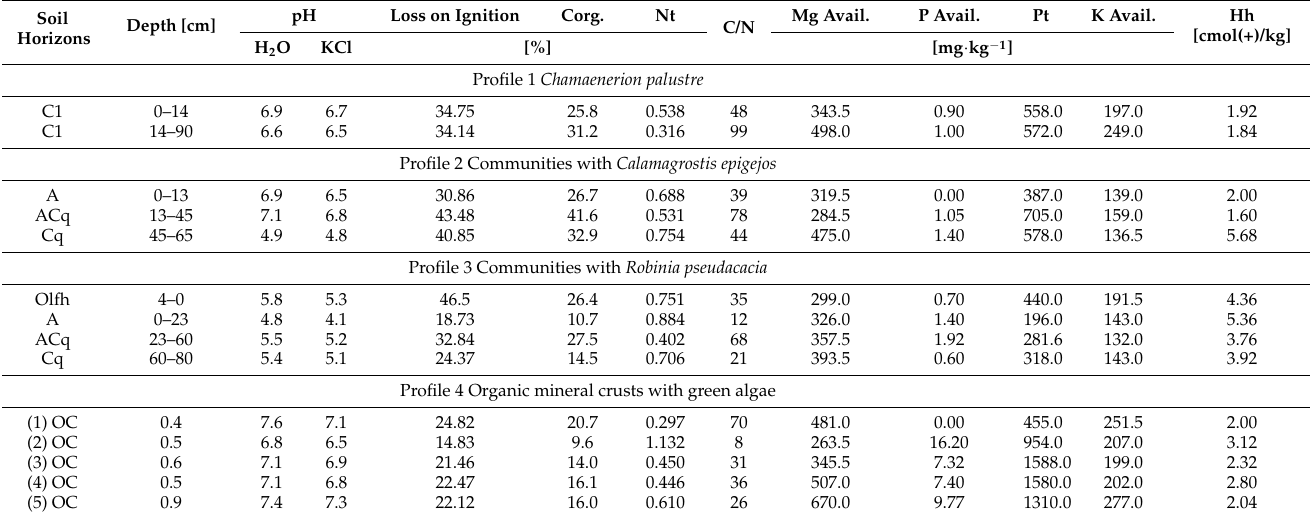
Table 2. Physico-chemical properties of soils in the spoil heap during the